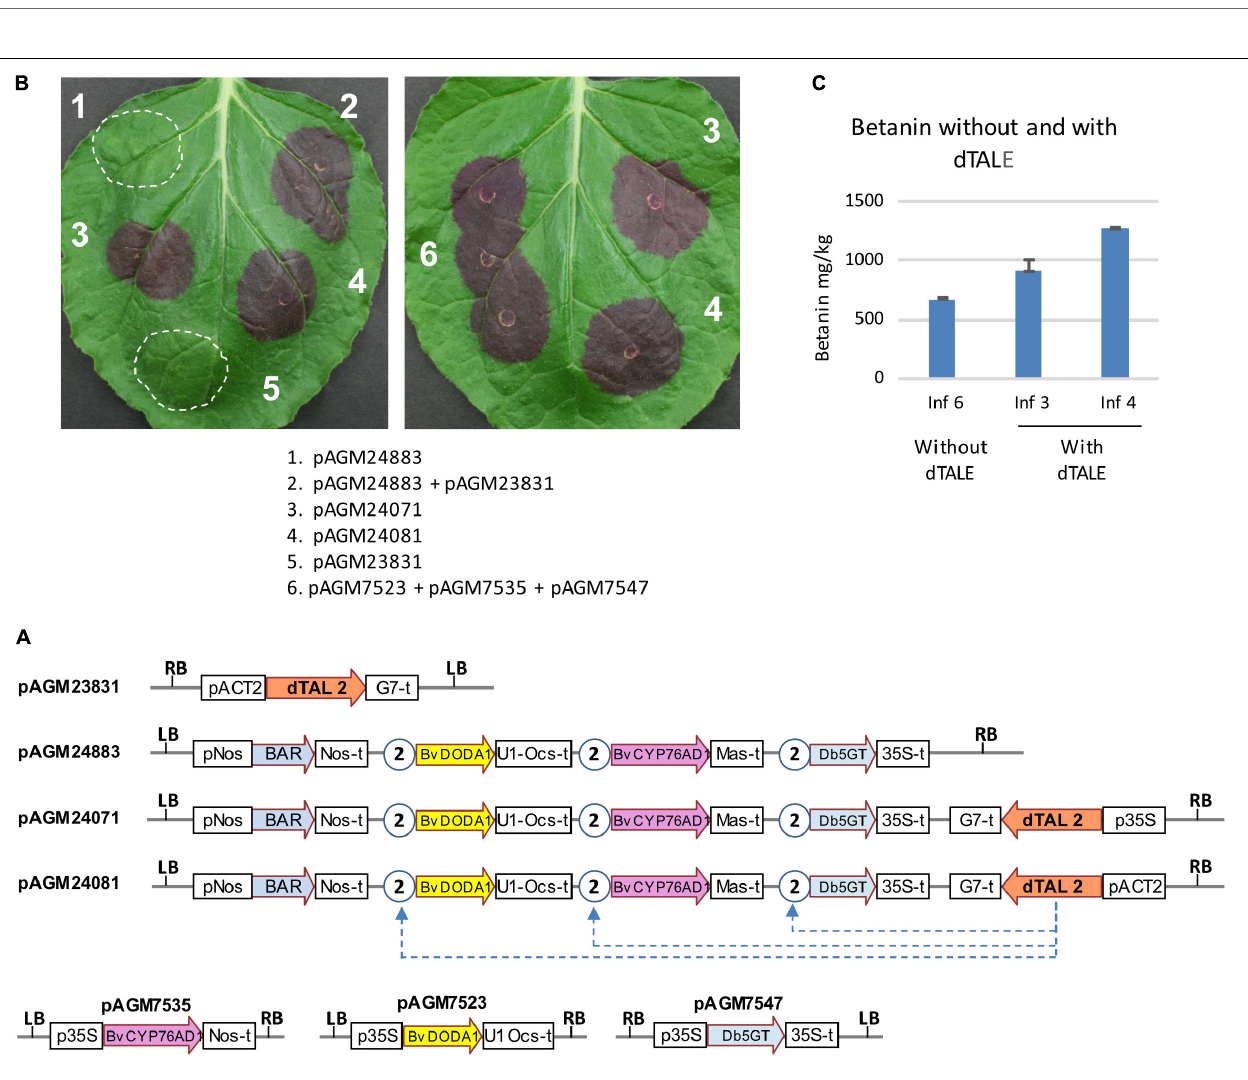
FIGURE 3 | Transient expression of dTALE constructs. (A) Structure of the constructs infiltrated in the benthamiana leaves shown in (B). P35S, 35S promoter; Nos-t, Nos terminator; U1 Ocs-t, 3 (cid:48) untranslated sequences from TMV U1 viral genome followed by Ocs terminator; 35S-t, 35S terminator; Mas-t, Mas terminator; G7-t, G7 terminator; pACT2, Arabidopsis ACT2 promoter; LB and RB, left and right T-DNA borders. The STAP promoter 2, shown as circles with the number 2, contain a binding site for the dTALE 2 protein. (B) Transient infiltration in N. benthamiana leaves. The description of the combination of constructs infiltrated in the leaves (infiltrations 1–6) are shown below. The pictures were taken 5 days after infiltration. (C) Quantification of betanin in the infiltrated leaf areas 3, 4, and 6 of the leaf shown on the right in (B)